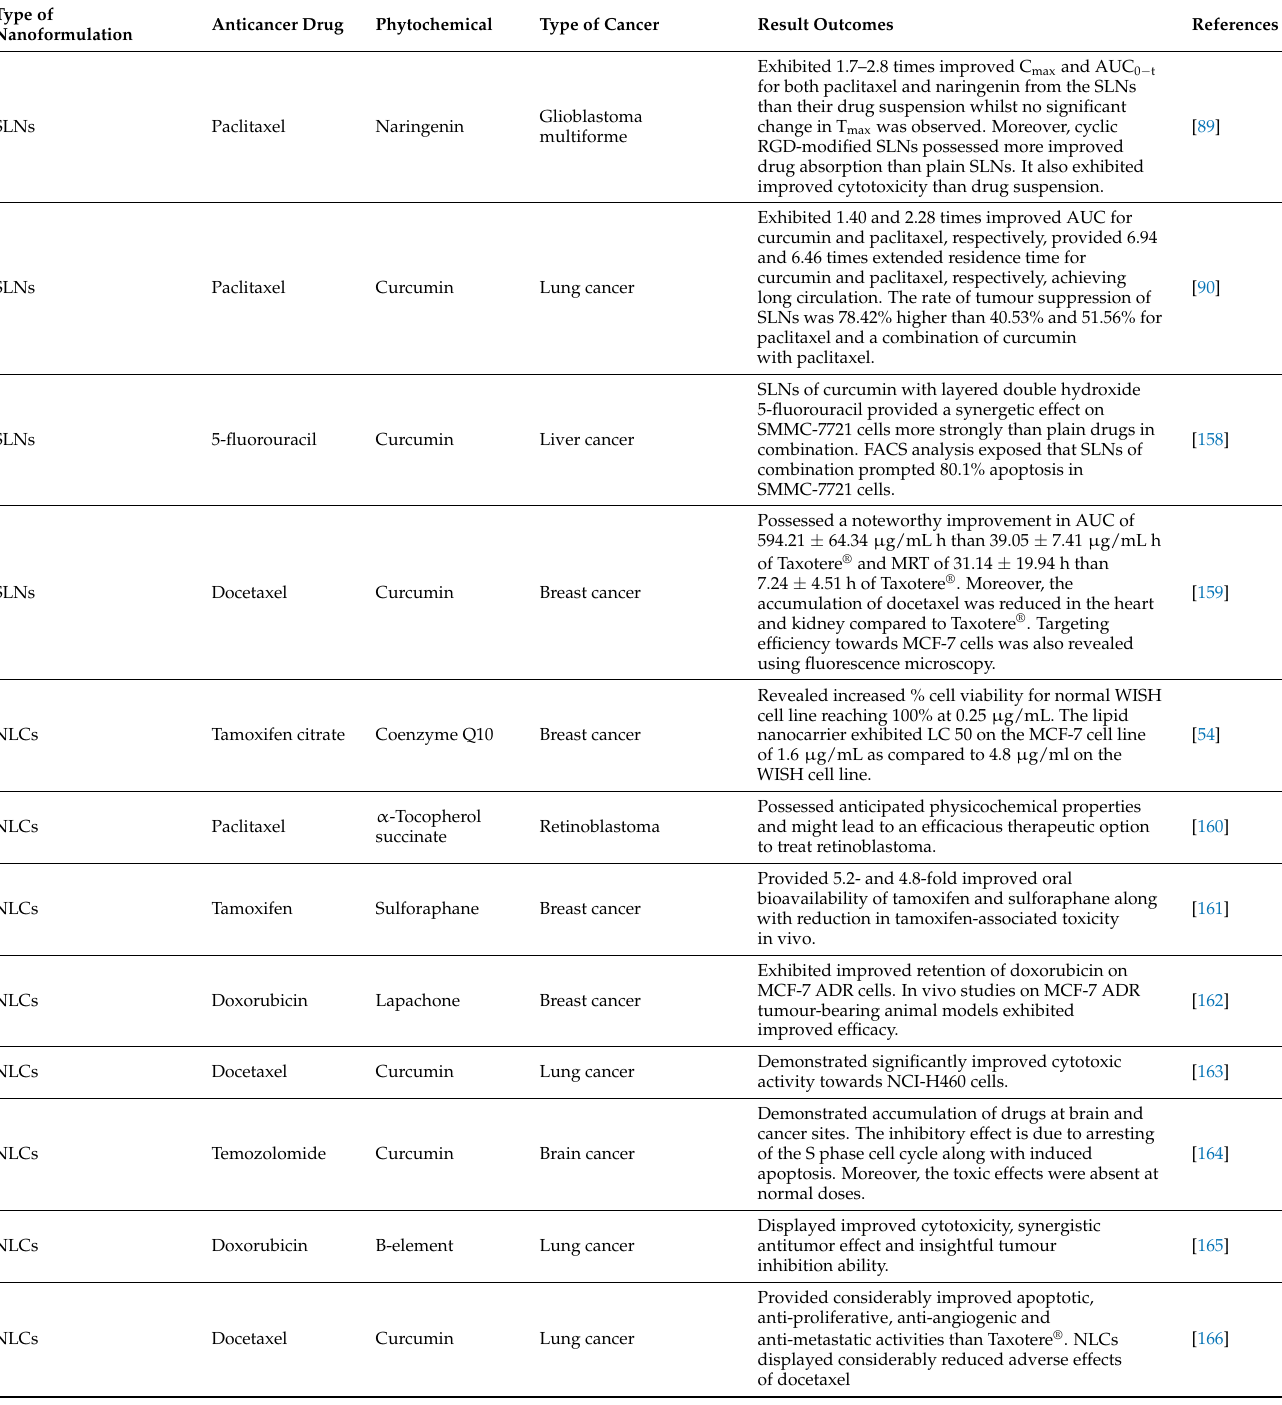
Table 2. List of nanoformulations for codelivery of anticancer drugs with